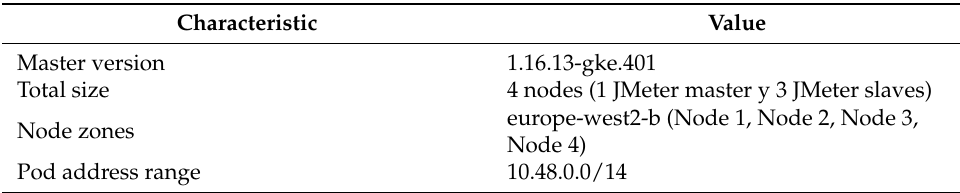
Table A4. JMeter–K8s cluster.